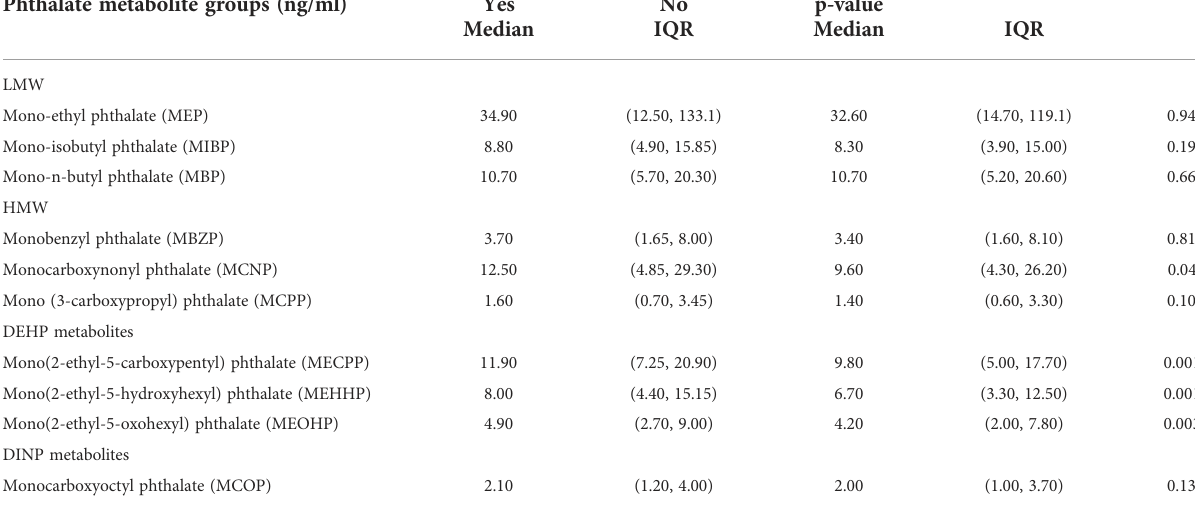
TABLE 4 Phthalate metabolite group medians and interquartile ranges (IQR) strati fi ed by adult-onset hypogonadism, NHANES 2013-2016. Phthalate metabolite groups (ng/ml)